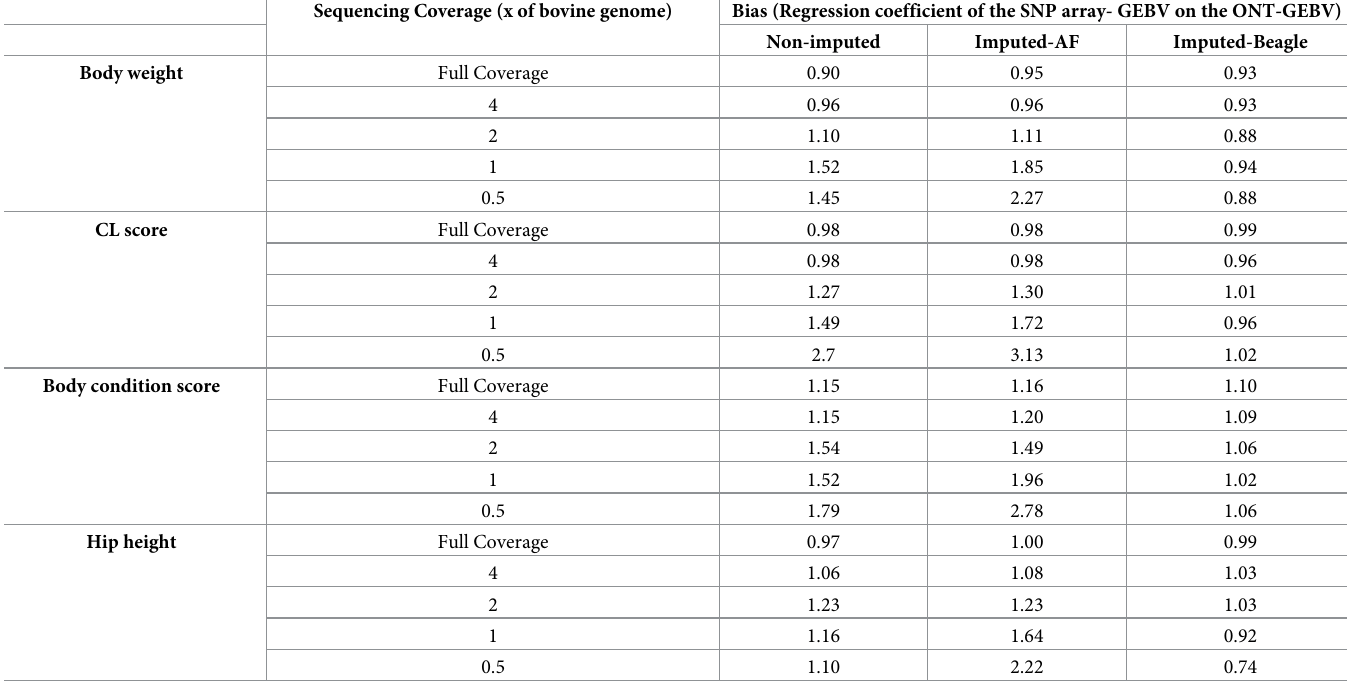
Table 2. Prediction bias for the different genotyping methods and sequencing coverages across the four traits. Sequencing Coverage (x of bovine